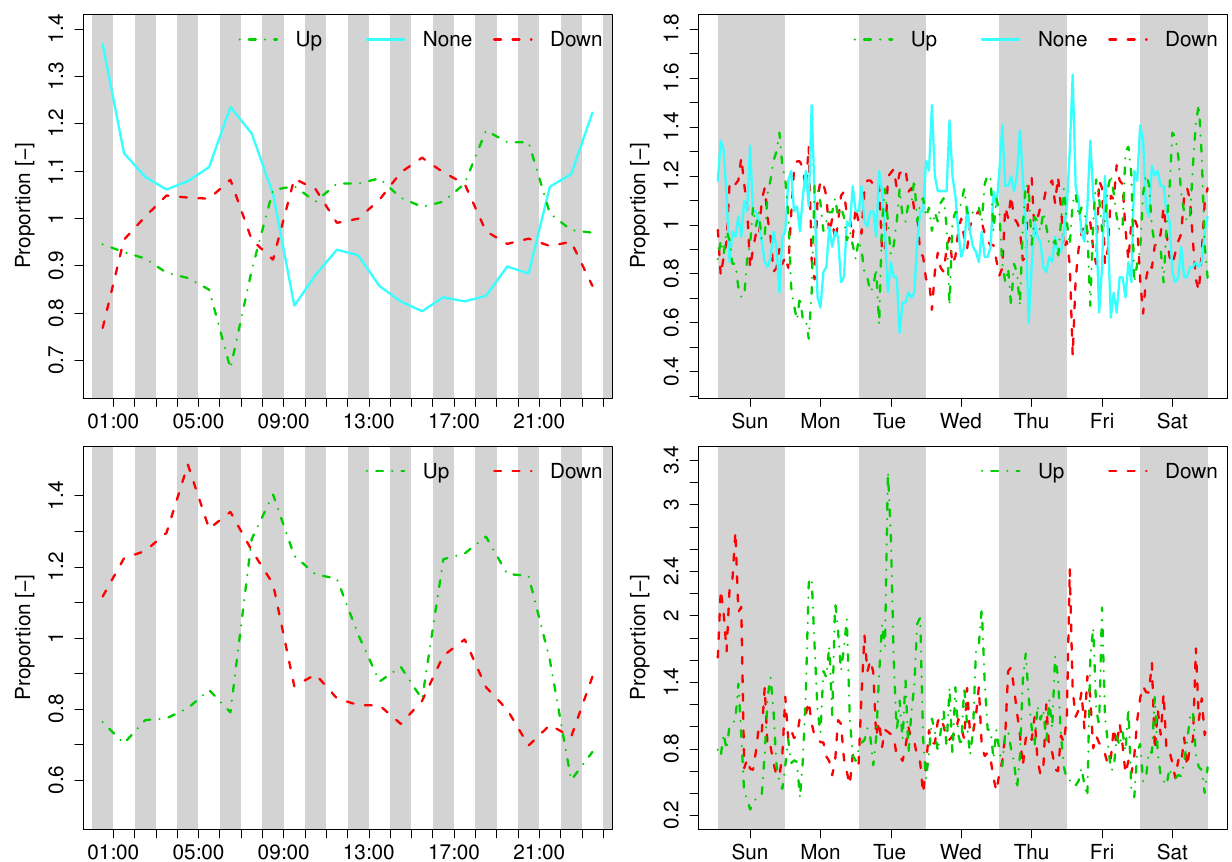
Figure 3. The intra-day and intra-week variations ( left and right columns, respectively) of the imbalance sign ( top row ) and imbalance penalties ( bottom row ), with respect to their empirical